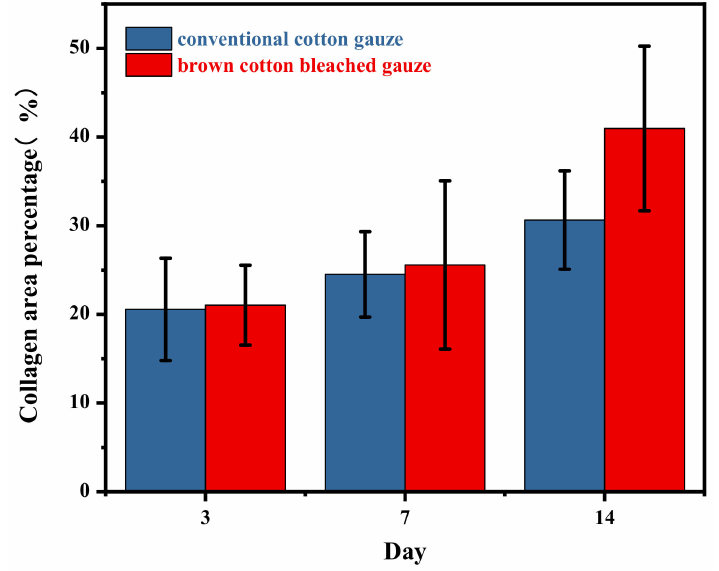
Figure 8. The area ratio occupied by